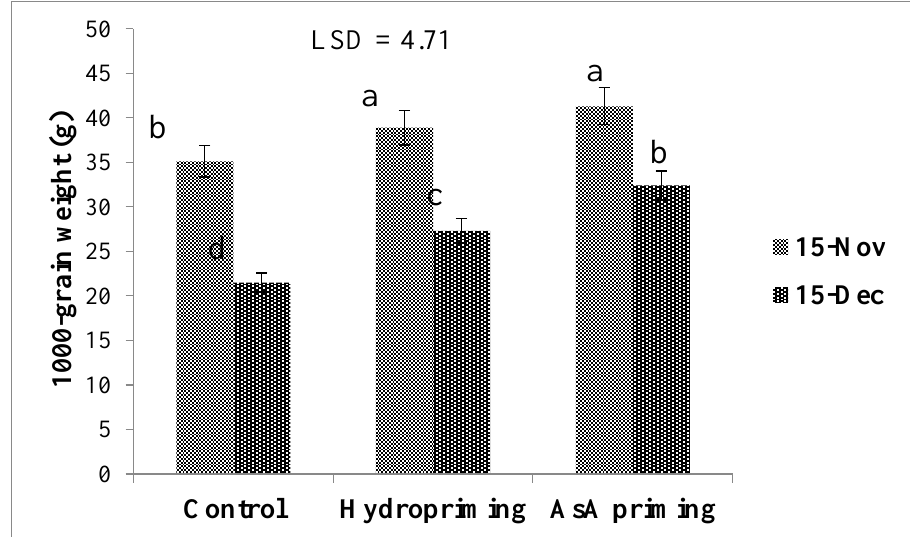
Figure 8. Interaction between priming techniques and sowing dates for 1000-grain weight during 2017. Means not sharing same letter (s) differ significantly at p ≤ 0.05.